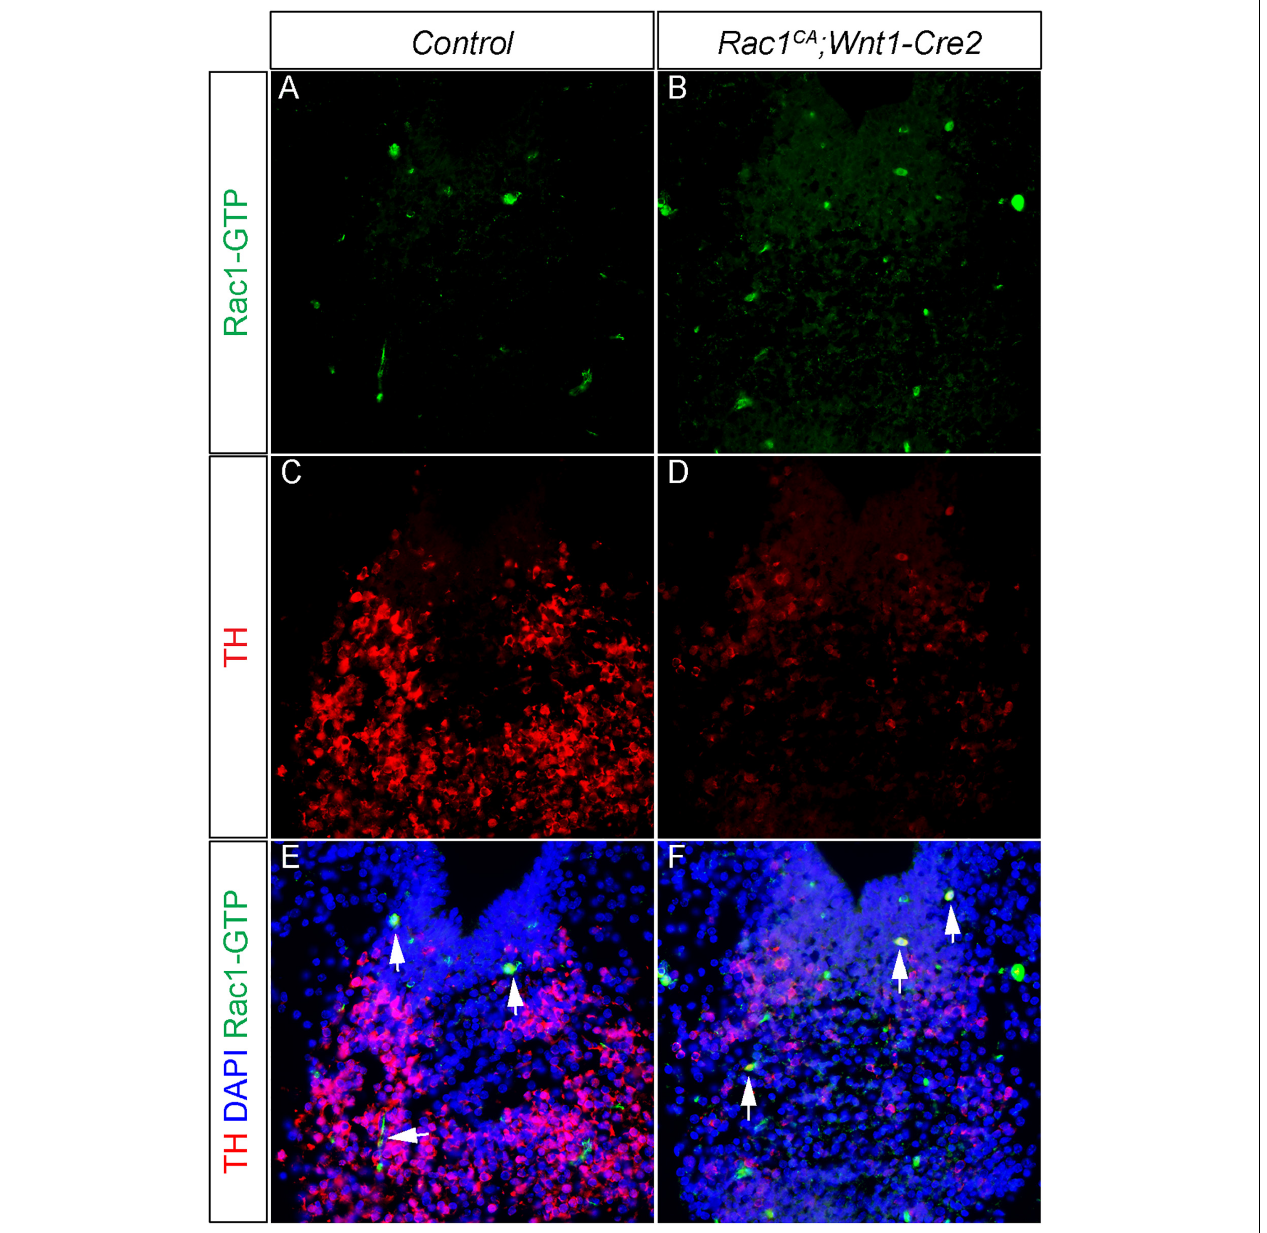
FIGURE 8 | Neural crest driven Rac1 G 12 V expression regulates mDA differentiation in a non-autonomous manner. (A,B) Immunostaining with anti Rac1-GTP antibody (green) on coronal sections of E13.5 littermate control and Rac1 CA ;Wnt1-Cre2 embryo at the midbrain level. (C,D) Immunostaining with anti TH antibody (red) on same sections of A,B . (E,F) Merged images of A–D with DAPI staining (blue). Blank arrows point to cells express both TH and